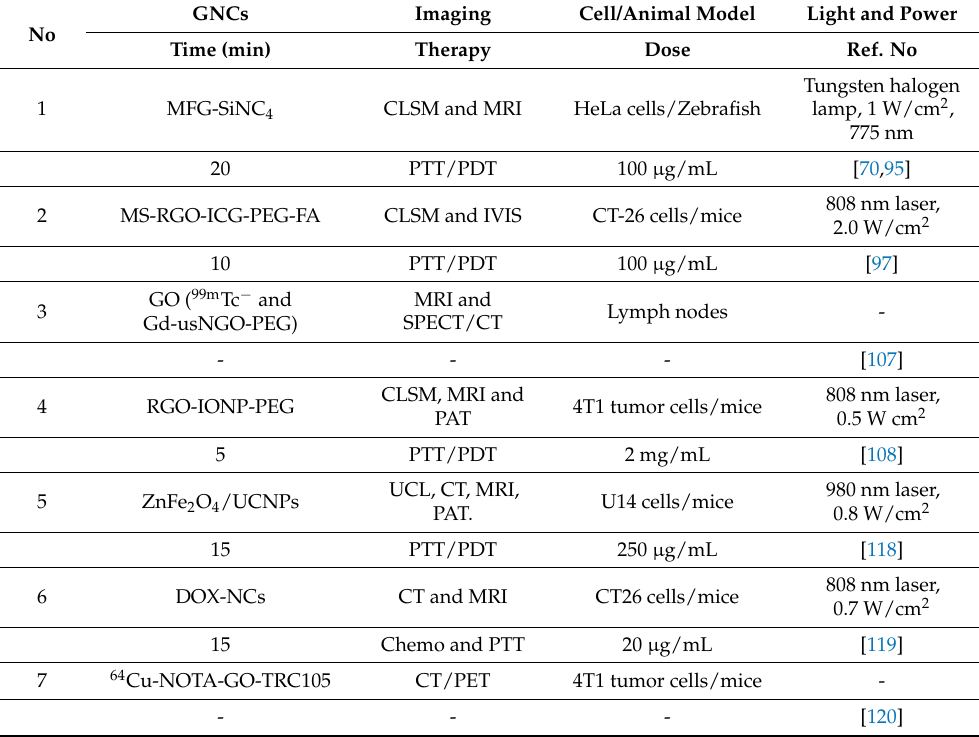
Table 1. Self-comparison of GNCs phototheranostic ability for cancer and bacterial